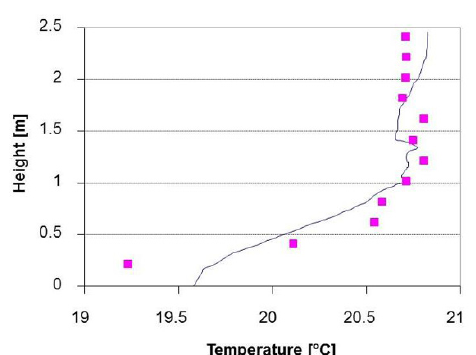
mannequin, (position AIRV). Temperatures are measured in 4 points to the left of the mannequin 0.1 m from the wall (position AIRT) and behind the mannequin (position VerticalT).